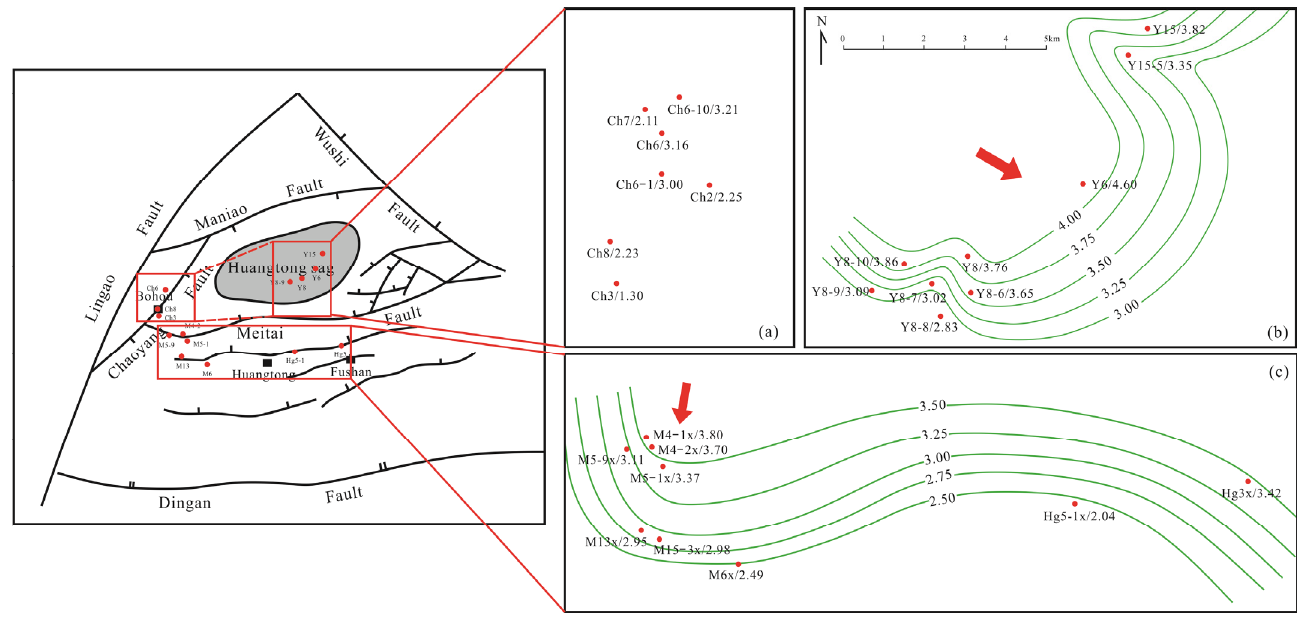
Figure 12. Isopleth map of 4-/1-MDBT of oils showing the oil migration orientation and charging pathways in the Chaoyang area ( a ), Yong’an area ( b ) and Hongguang-Meitai area ( c ). Note: MDBT, methyldibenzothiophene.